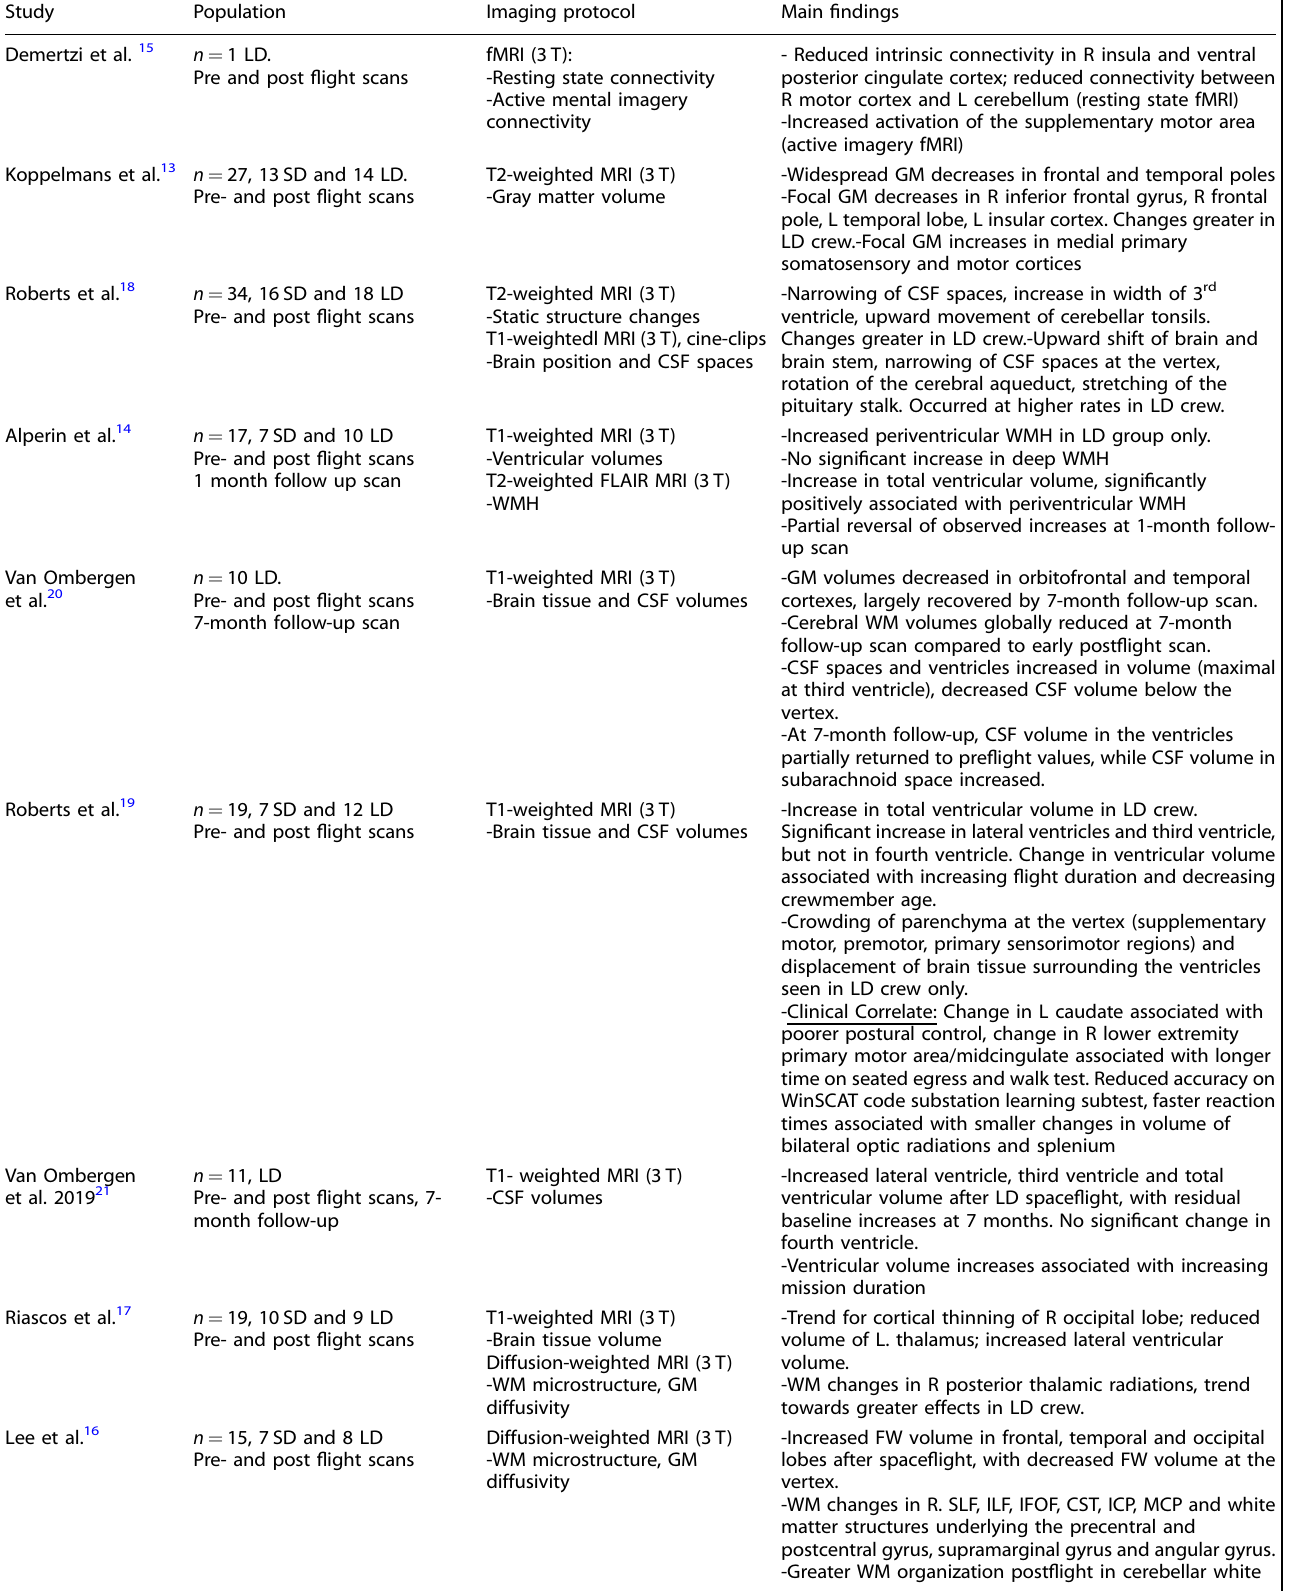
Table 1. Summary of MRI fi ndings from studies conducted in US astronauts and Russian cosmonauts pre and post space fl ight and potential clinical correlates where